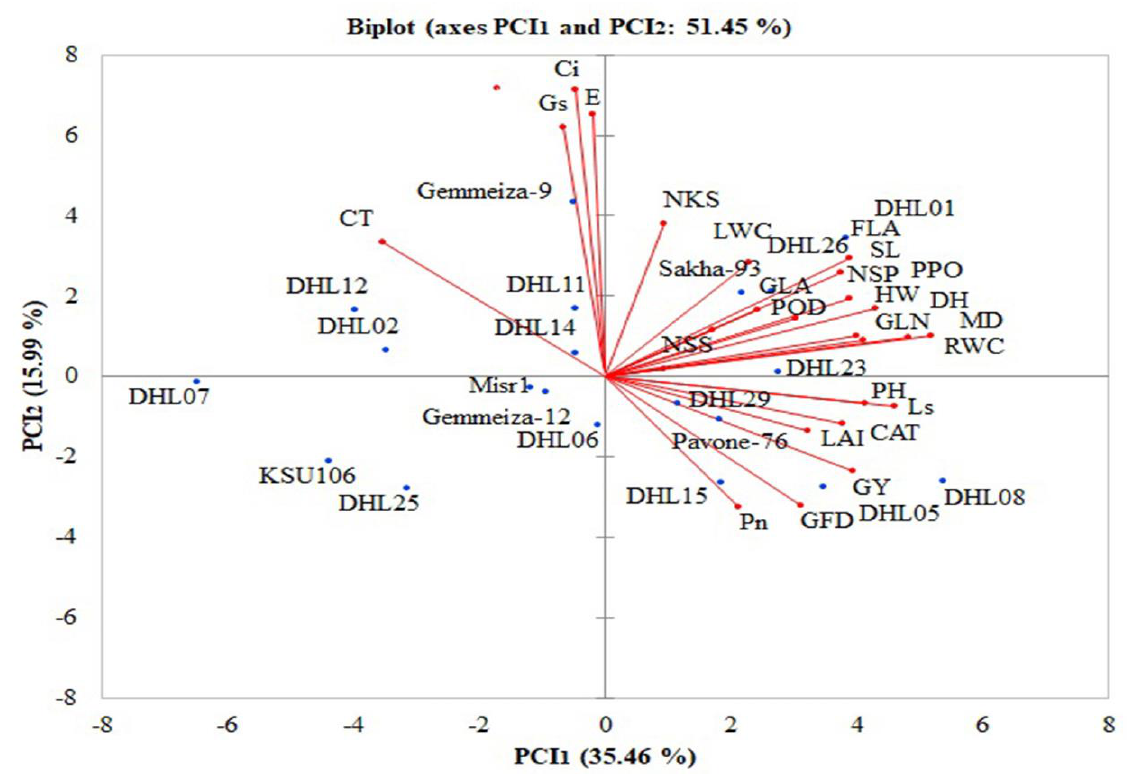
Figure 1. Biplot for the first two principle components in the principle component analysis of 20 wheat genotypes in two seasons (S1 and S2) for 25 heat tolerance indices.